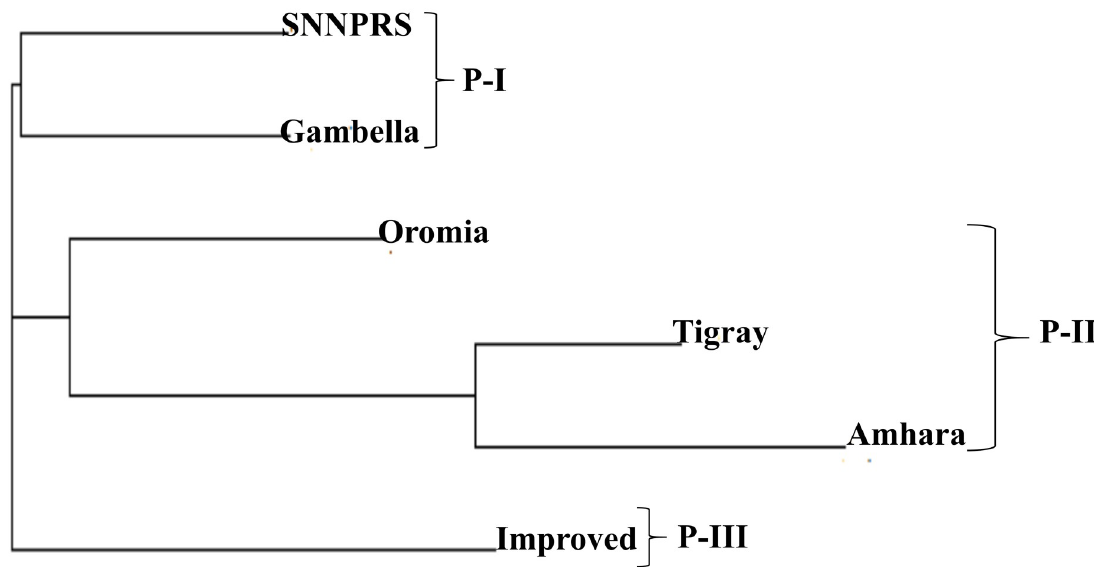
Fig 3. Neighbor joining tree among five different regions of Ethiopia and introduced improved cultivars based on pairwise FST.